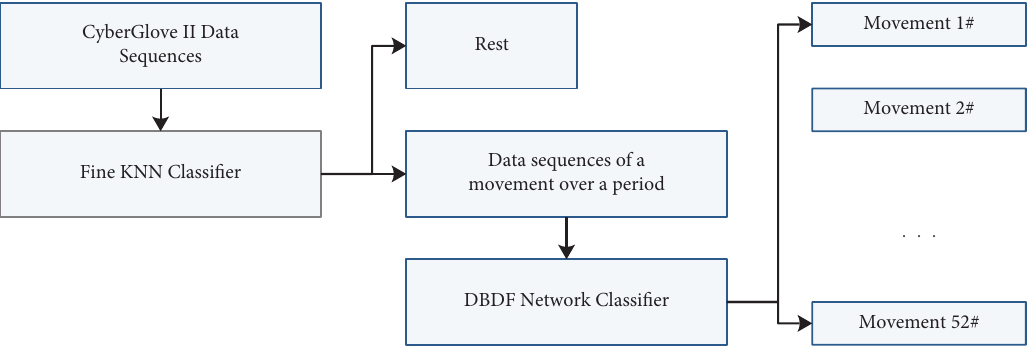
Figure 1: The structure of this classification